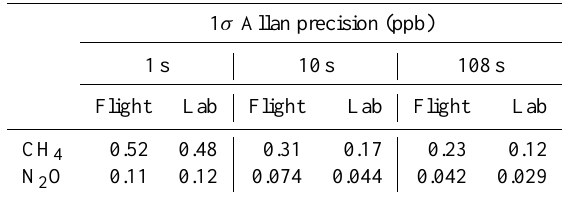
Table 3. Allan precision for QCLAS measurement of CH 4 and N 2 O, both during ambient in-flight sampling and whilst sampling a compressed air cylinder in the laboratory, given for averaging times of 1, 10 and 108s.